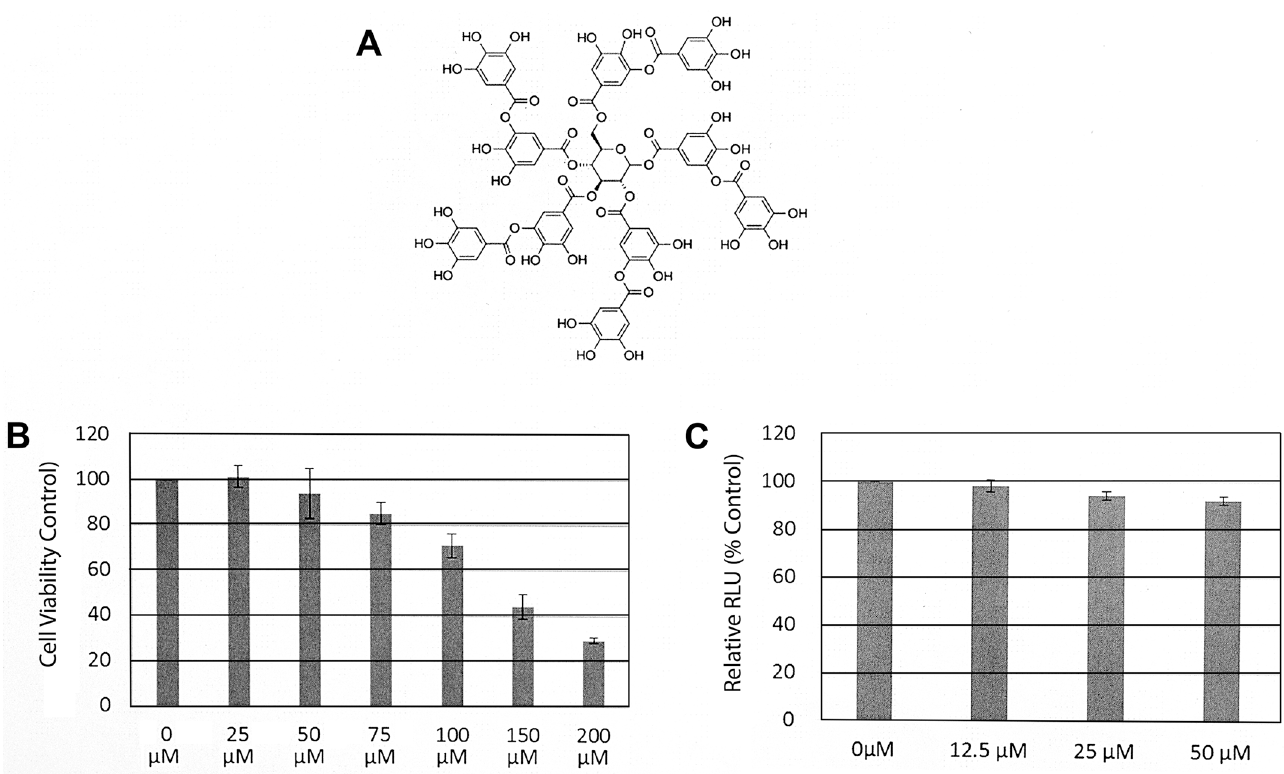
Fig 1. The structure of tannic acid and toxicity assays. (A) Molecular structure of tannic acid. (B) Cell toxicity of tannic acid as measured by cell viability. The viability of Huh7.5 cells was determined using a CellTiter 96 Aqueous One solution cell proliferation assay as described in Materials and Methods. Each experiment was performed in triplicate and repeated at least three times. The CC 50 based on these studies was 146.1 ± 6.2 μ M. (C) The direct effect of tannic acid on Renilla luciferase (Rluc) assays: HCV JFH1-AM120-Rluc infected cell lysates containing Rluc protein was mixed with increasing concentrations of tannic acid for ten minutes at room temperature and luciferase activity was measured as described in Materials and Methods. Assays were done in triplicate and experiments done three times. Results are presented as the mean ± standard deviation (SD) (n = 9) of relative light units (RLU). No significant difference (Student ’ s t-test p > 0.05) in Rluc assay results were observed with tannic acid concentrations (cid:1) 50 μ M.